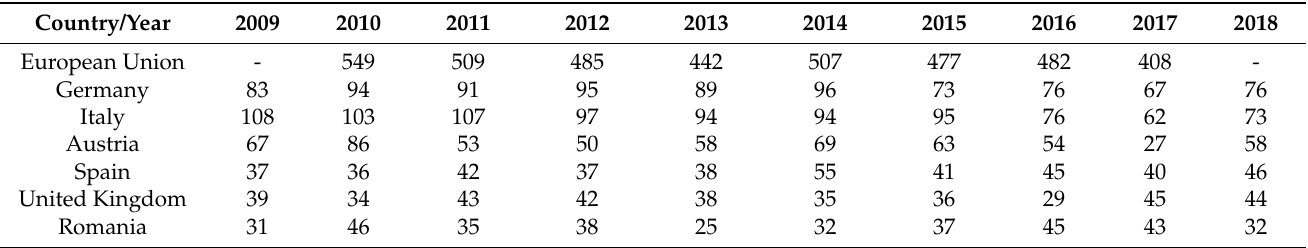
Table A1. Fatal accidents (number of accidents per 100,000 workers) in agriculture, forestry, and fishing in